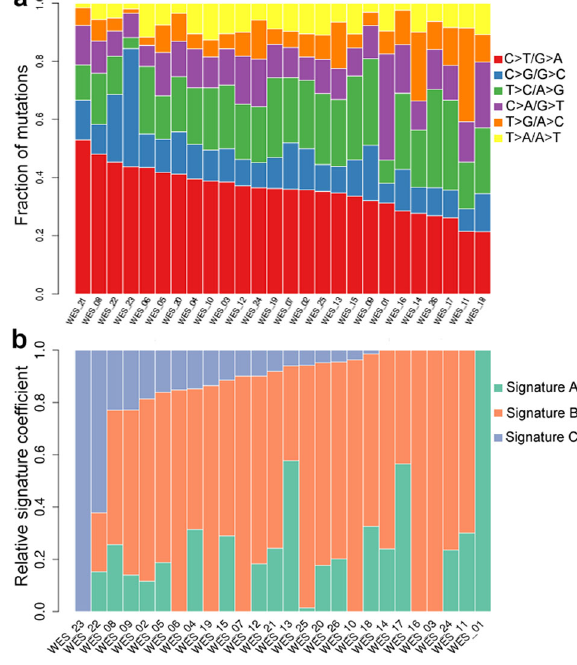
Fig. 2 Mutation spectra and mutation signatures among EPC samples. a The left column depicted the mutation spectrum across all tumor samples. Red represented C > T/G > A mutations, blue represents C > G/G > C mutations, green represented T > C/A > G mutations, purple represented C > A/G > T mutations, orange represented T > G/A > C mutations, and yellow represented T > A/ A > T mutations. The Y-axis indicated the proportion of samples with the mutations. b Nonnegative matrix factorization cluster analyses acquired three different mutation signatures. The Y-axis indicated the proportion of acquired mutation